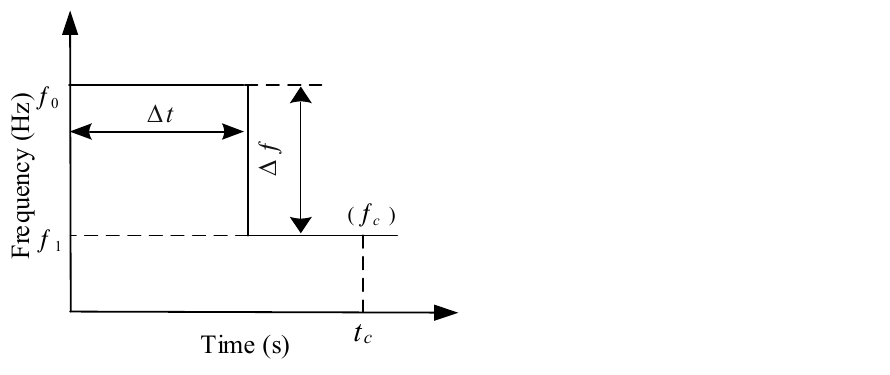
Figure 6. Multistep decline frequency time control curve.